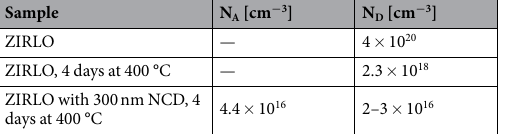
samples after hot steam exposure showed both p-type (acceptor-containing) and n-type semiconductive behavior (Table 2). The work function values obtained with the NanoESCA system support the results of the capacitance meas- urements. Typical Ultraviolet Photoemission Spectroscopy (UPS) spectra used for work function determination are presented in Fig. S5. Compared with standard ZrO 228–30 , uncoated ZIRLO samples exposed to hot steam for 4 days at 400 °C were found to have a relatively low ZrO 2 work function of 2.0 eV, thus indicating an elevated posi- tion of the Fermi level. The Fermi level moves up in the presence of donors, and a high level of donors was indeed detected (Table 2). By contrast, for NCD-coated ZIRLO samples exposed to the same conditions, we observed a higher value of the surface ZrO 2 work function, 4.0 eV (Fig. S5). This result suggested the presence of acceptors, thereby implying p-type semiconductivity, i.e., a position of the Fermi level that is closer to the valence band. The results presented in Table 2 are well consistent with such an interpretation.